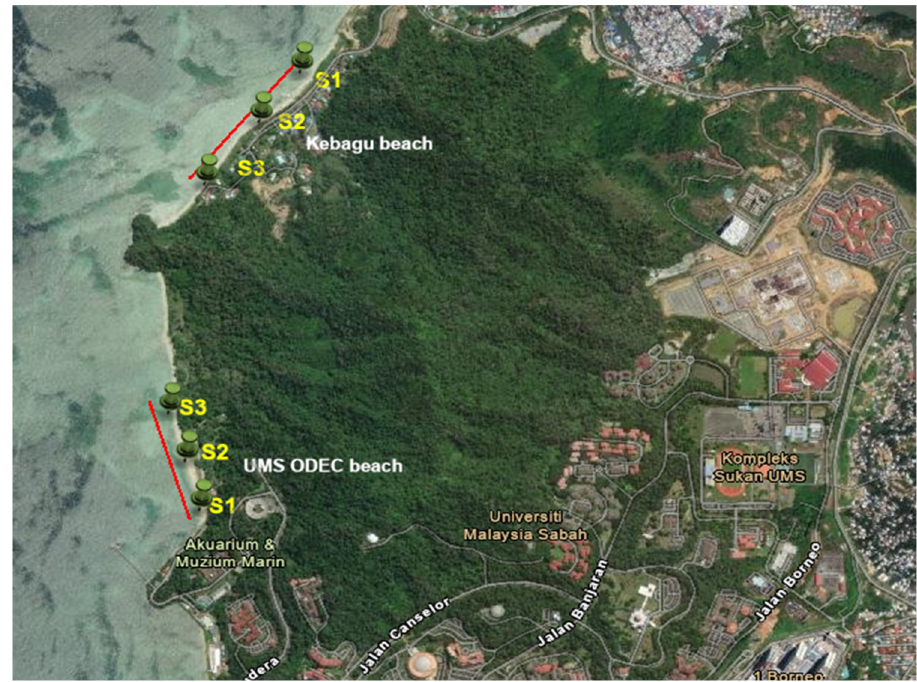
Figure 1. Overview of sampling locations at UMS ODEC Beach and Kebagu Beach, Kota Kinabalu, Sabah, Malaysia.